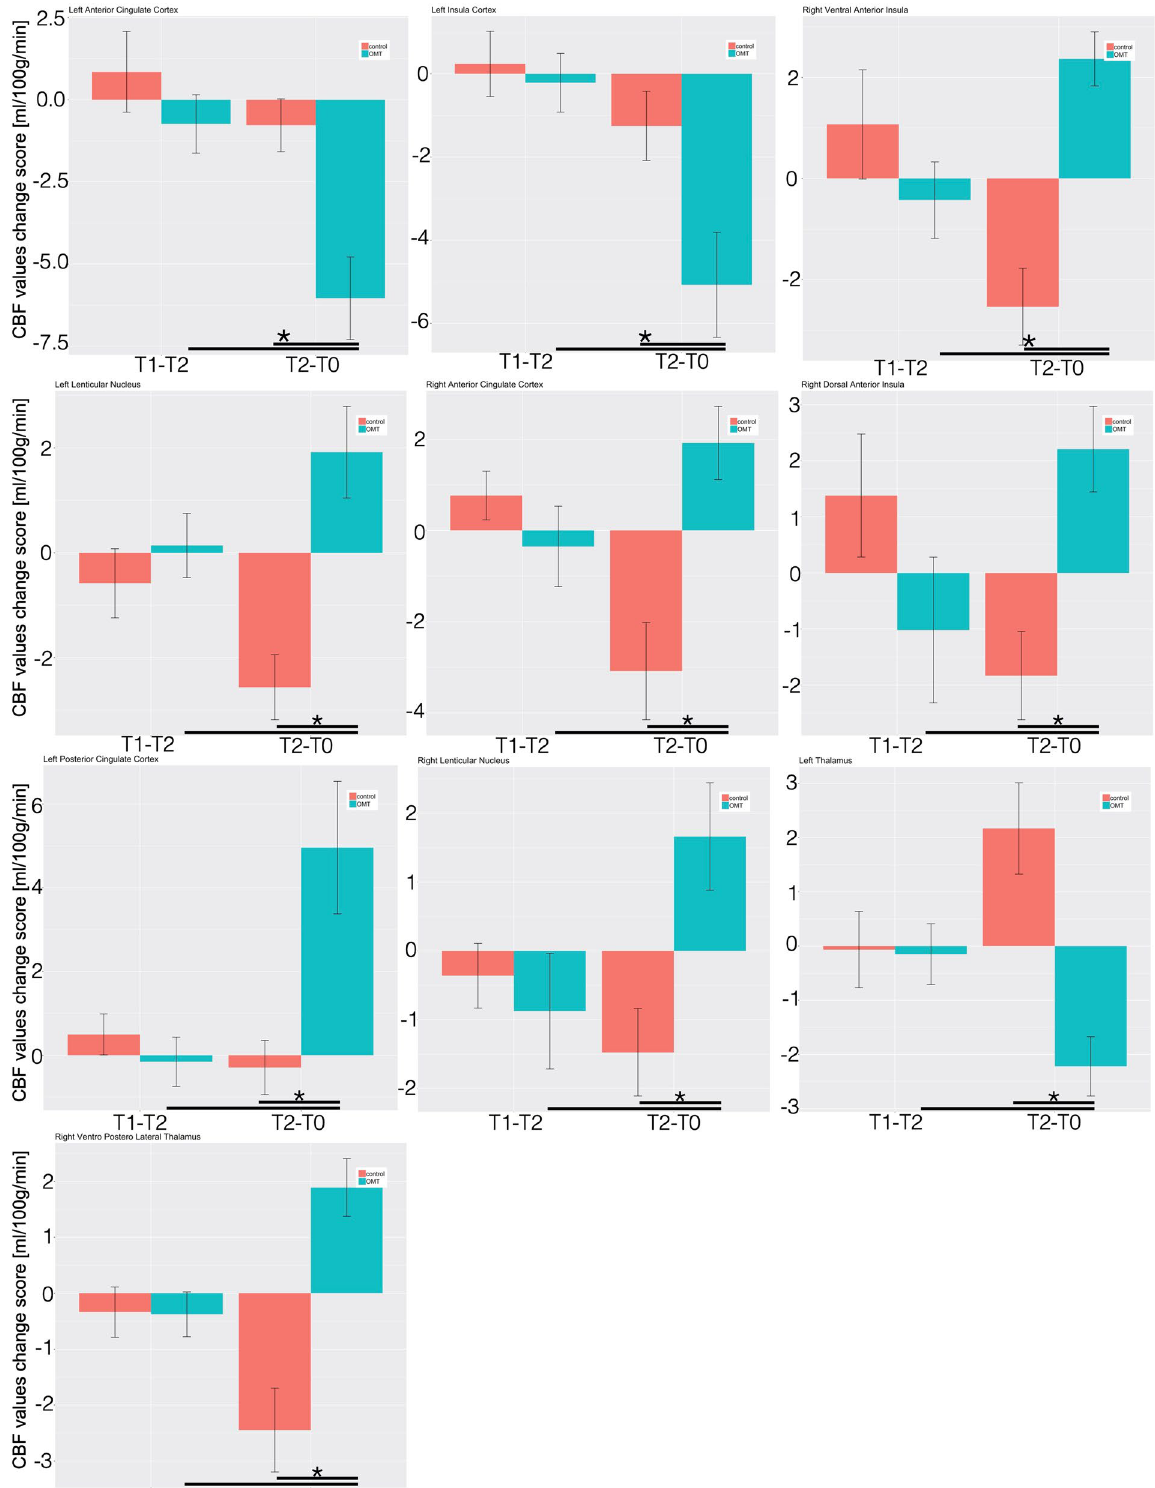
Figure 2. Longitudinal CBF delta changes. The figure shows the longitudinal CBF mean change within the regions of interest for the two groups. *Statistically significant differences (p < 0.05) between